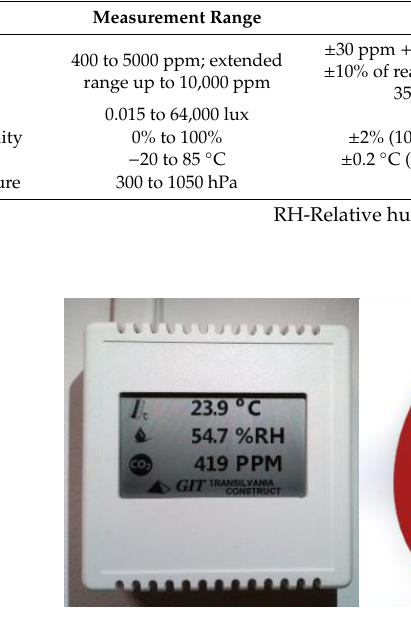
Figure 9. Sensing units for air temperature, humidity and CO 2 content.